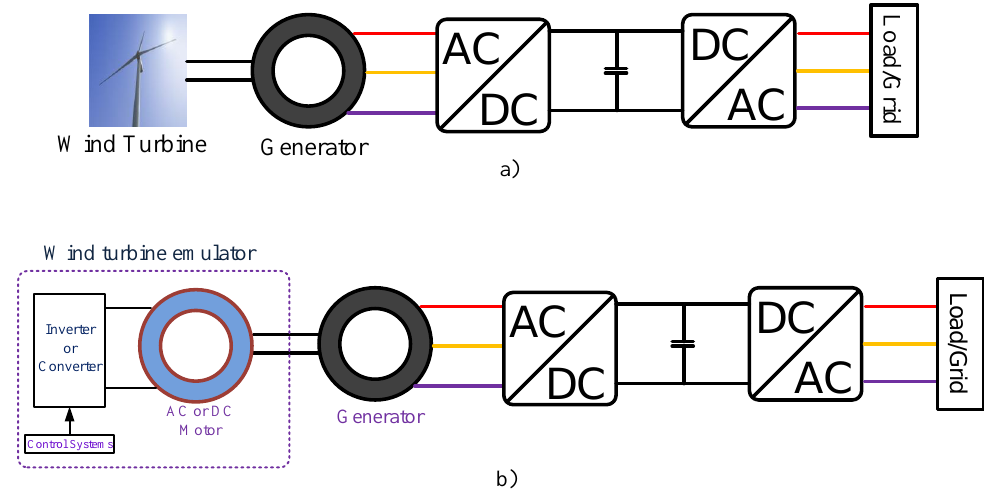
Figure 1. ( a ) Wind energy conversion systems and ( b ) Wind turbine